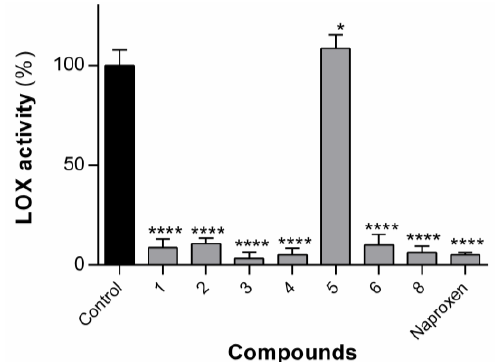
Figure 5. LOX activity in the presence of compounds 1 – 6 and 8 at 100 µM. Values are shown with mean ± SD. **** p ≤ 0.0001. The results for compound 1 and 2 , reported previously, are included for comparison purposes. Table 1. IC 50 values for LOX inhibition.